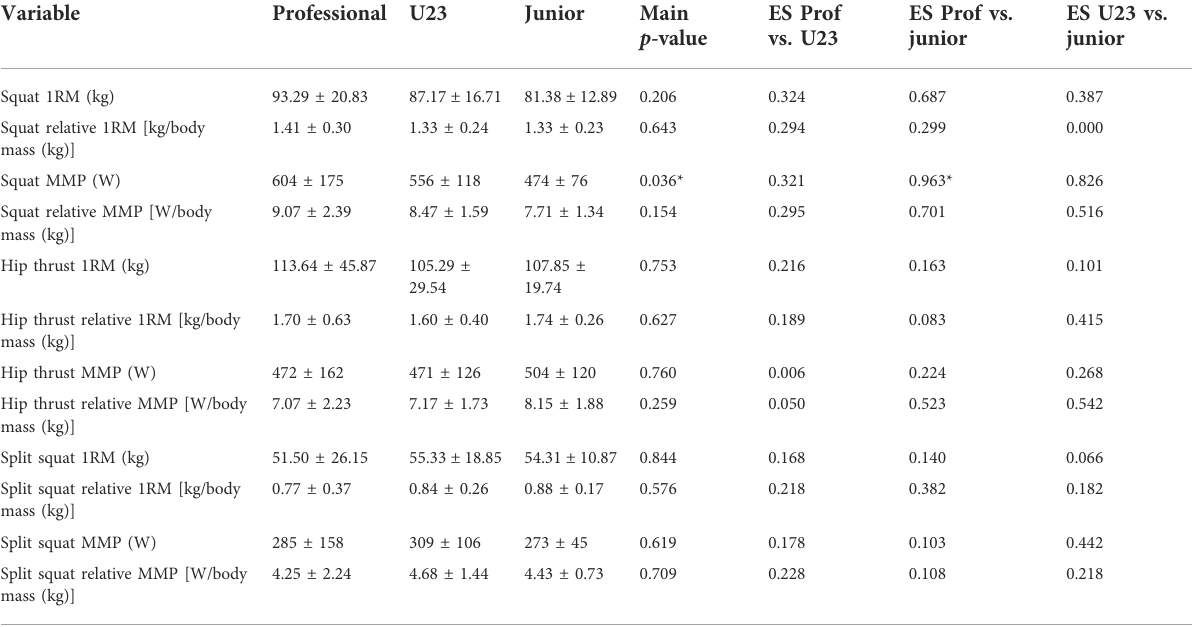
TABLE 2 Differences in strength/power indicators between